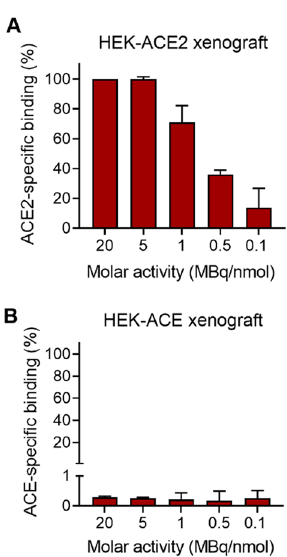
Fig. 8 Quantification of autoradiograms obtained after incubation of A frozen HEK‑ACE2 xenograft sections and B frozen HEK‑ACE xenograft sections to [ 67 Ga]Ga‑HBED‑CC‑DX600. The signal intensity is presented as the percentage of the signal intensity obtained from the HEK‑ACE2 xenograft section incubated with [ 67 Ga] Ga‑HBED‑CC‑DX600 labeled at the highest molar activity (20 MBq/ nmol) which was set as